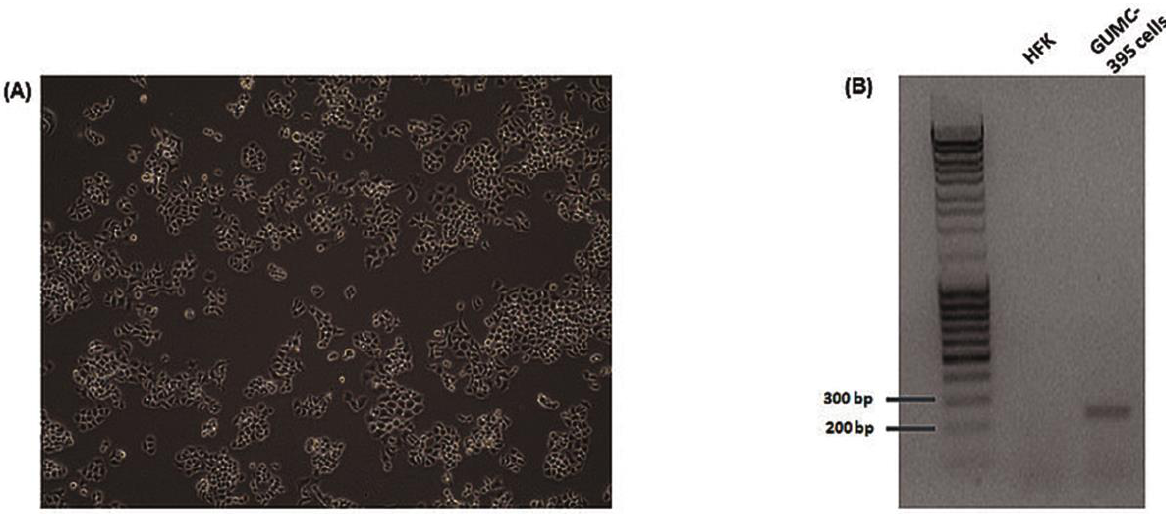
Figure 1. Phase-contrast photograph and HPV detection of GUMC-395. ( A ) Cell morphology of GUMC-395 growing on collagen-coated flasks. ( B ) HPV16 detection in GUMC-395 but not in HFK by PCR assay. DNAs were isolated from GUMC-395 or HFKs. PCR reactions were performed with an HPV-16-specific primer set. PCR products were separated on an agarose gel.